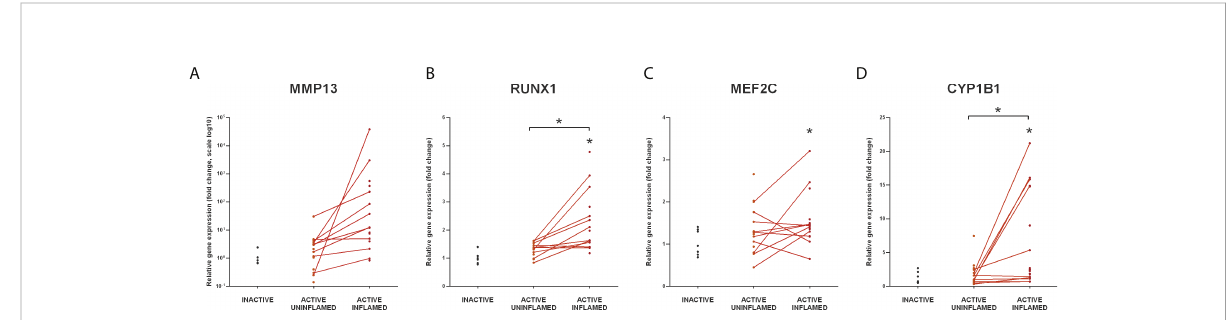
FIGURE 7 Increased expression of miR-27b targets in the in fl amed human colon samples. Relative expression of MMP13 (A) , RUNX1 (B) , MEF2C (C) and CYP1B1 (D) is shown from inactive (left), active unin fl amed (middle) and active in fl amed (right) colon samples of IBD patients. Dots represent individual values, and the lines connect unin fl amed and in fl amed samples from the same IBD patient; * p